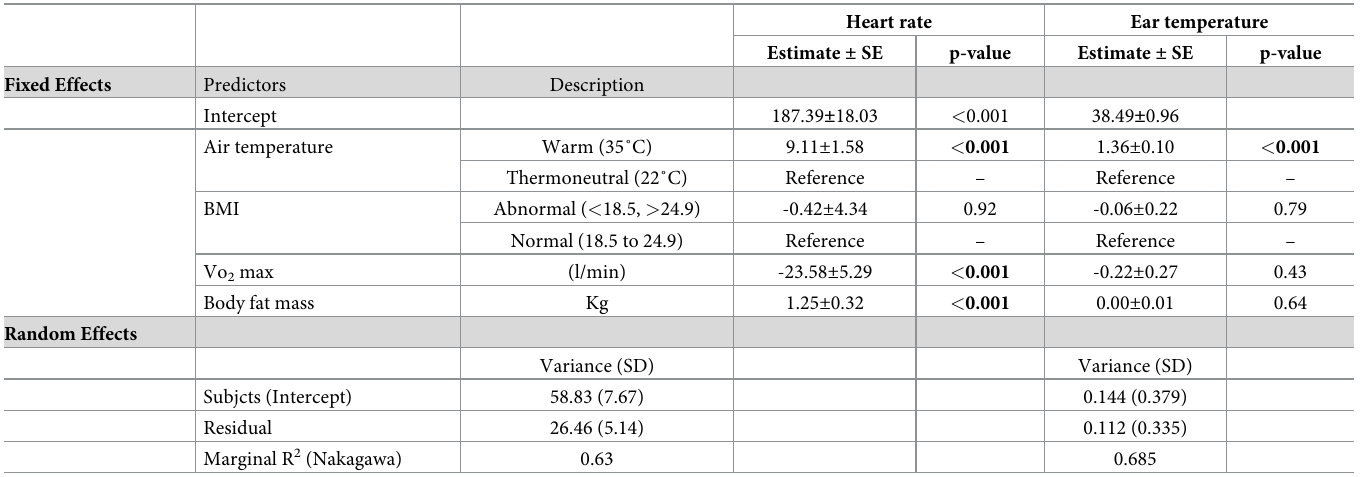
Table 4. The LMM model for analyzing the effects of body characteristics on heat tolerance